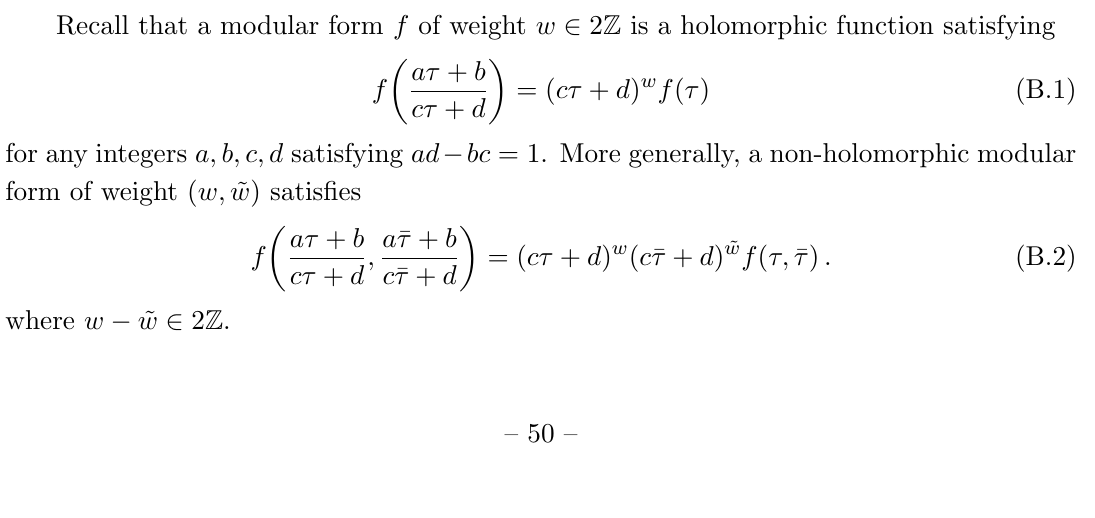
Figure 7. Contributions of the second page E K (cid:0) 1 ( S 3 = (cid:0)) = K 1 ( S 3 = (cid:0)) (pink,